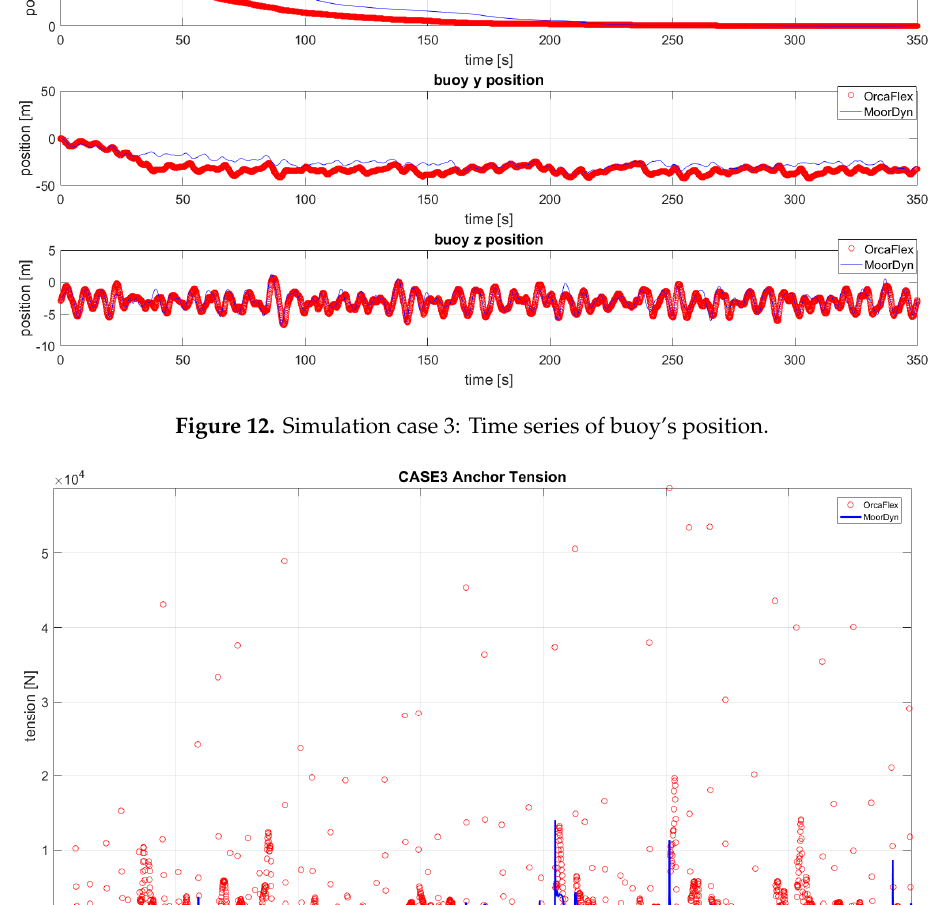
Figure 14. Current speed profile along the depth. Perfect agreement between OrcaFlex and adapted MoorDyn are found when comparing positions of the buoy (Figure 15). There is a minor discrepancy when comparing anchor tension. As it is shown in Figure 16, OrcaFlex gives slightly higher tension.